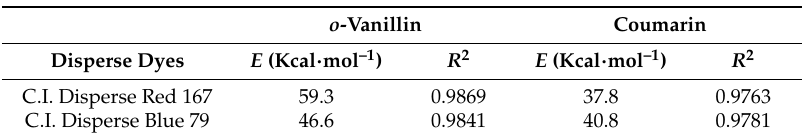
Table 6. Activation energy (E) and correlation coefficient (R 2 ) for the two dyes studied in the presence of o -vanillin or coumarin auxiliaries.